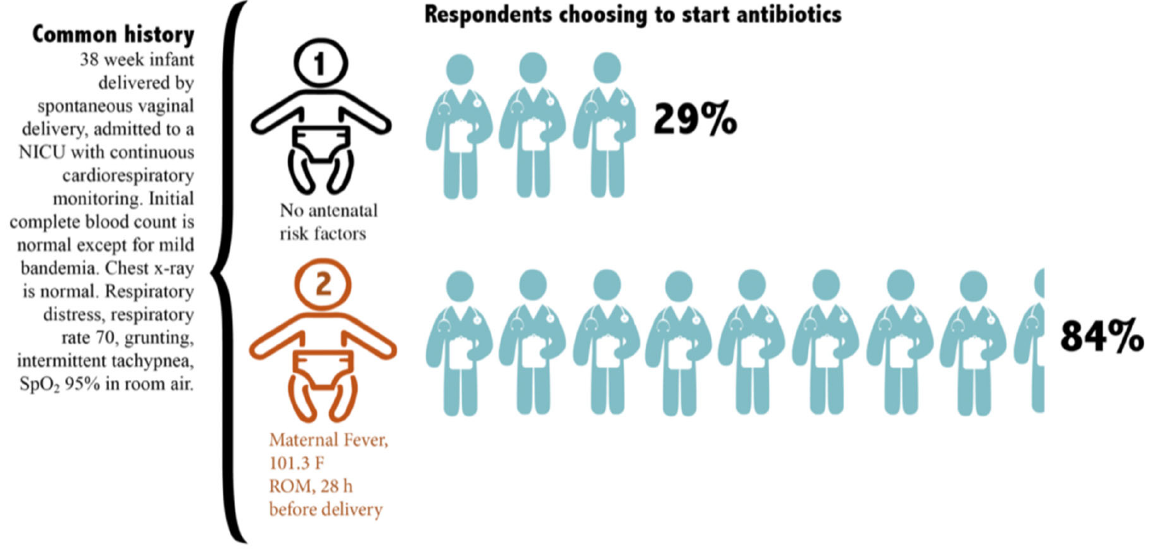
Figure 3. The graphic displays the initial common history of a term newborn vignette. The first variable ( 1 ) is no antenatal sepsis risk factors. The second variable ( 2 ) added to the vignette is two antenatal sepsis risk factors. The blue arrow highlights the proportion of prescribers that changed their decision by choosing to start antibiotics in response to the two antenatal sepsis risk factors.